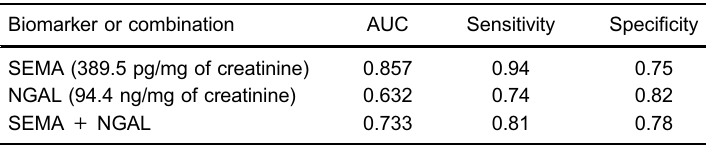
Table 3. Predictive features for various combinations of biomarkers at 2 h post- surgery.